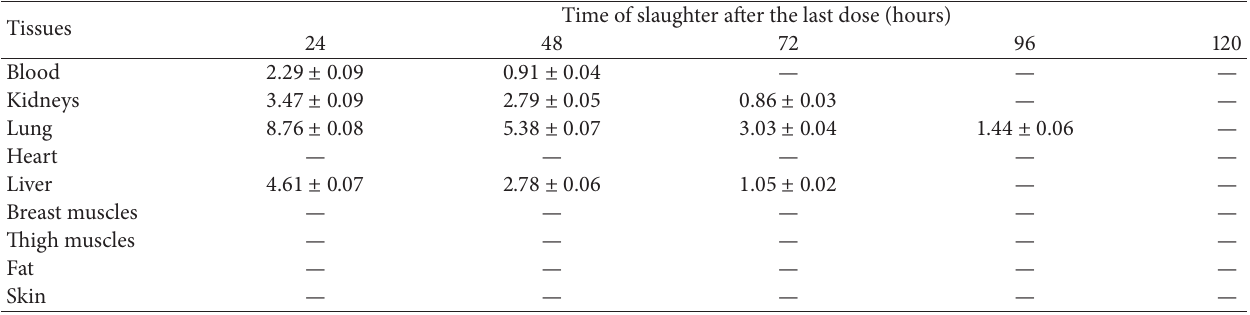
Table 1: Blood ( 𝜇 g/mL) and tissue ( 𝜇 g/g) concentrations of tilmicosin following oral administration of 25 mg/kg BW once daily for 5 consecutive days in broiler chicken ( 𝑛 = 5